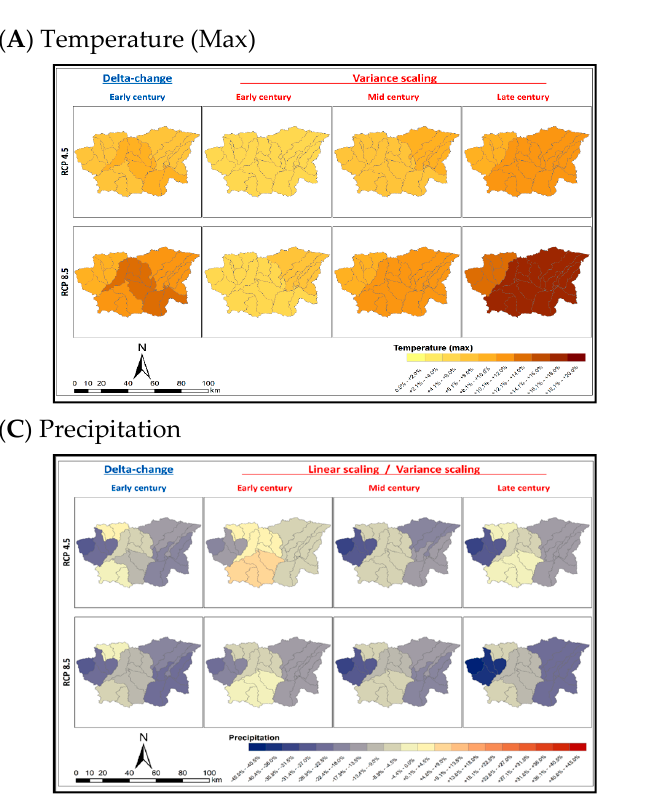
Figure 13. These maps represent the mean annual percent change of the key water balance component relative to the reference scenario. The spatial variability in streamflow, surface runoff, evapotranspiration, and water yield is attributed to the variability of downscaled RCM temperature and precipitation values over time and the relative location of the rainfall and meteorological stations.